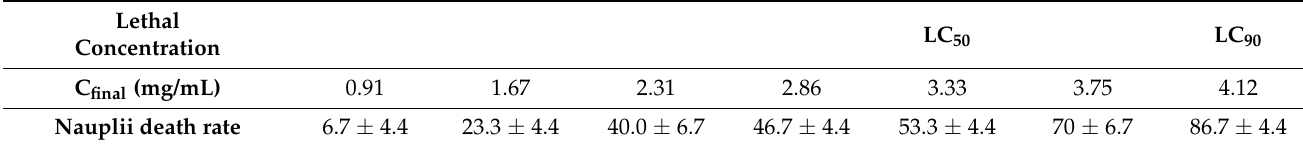
Table 12. Ecotoxicity test with sodium oxyacetate of CNSL ( 8 ) at pH